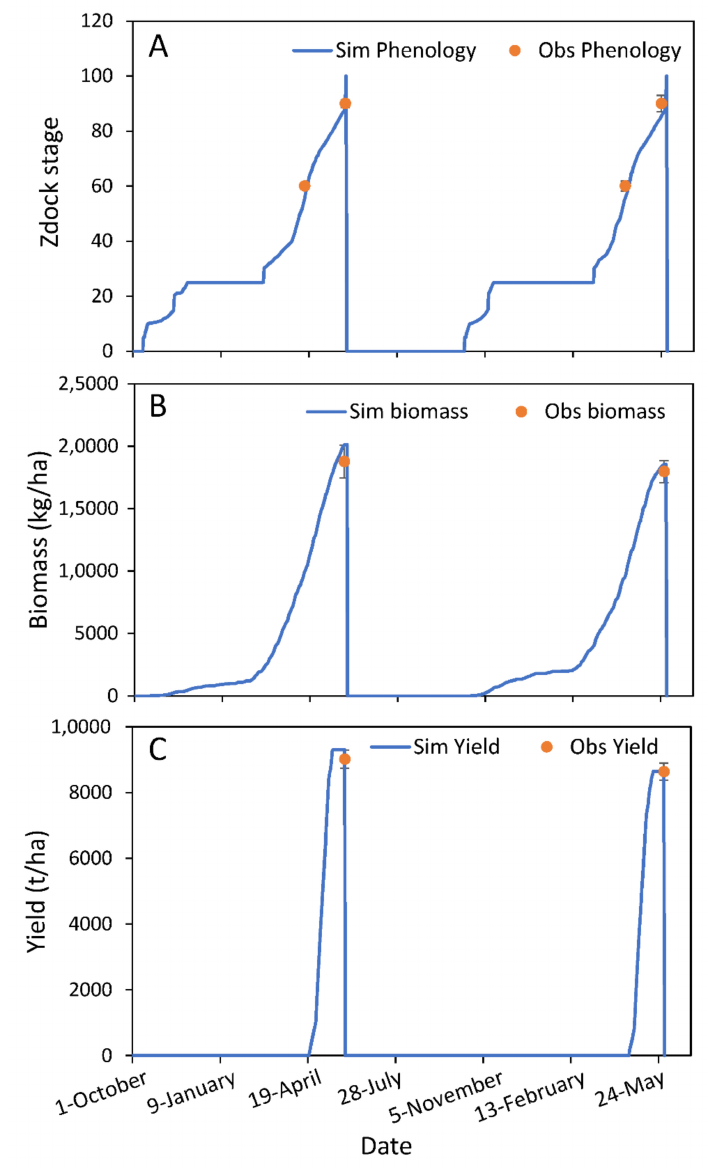
Figure 2. Simulated and observed phenology ( A ), maturity biomass ( B ) and grain yield ( C ) for “Jimai22” in 2016–2017 and 2017–2018 at